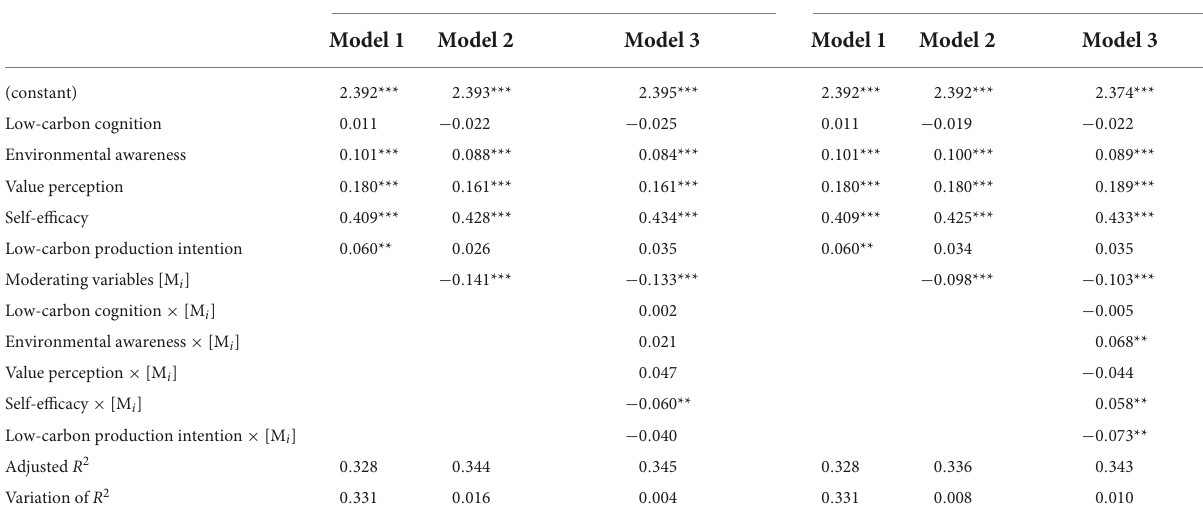
TABLE 8 Moderating effects of production implementation cost and socio-environmental factor.